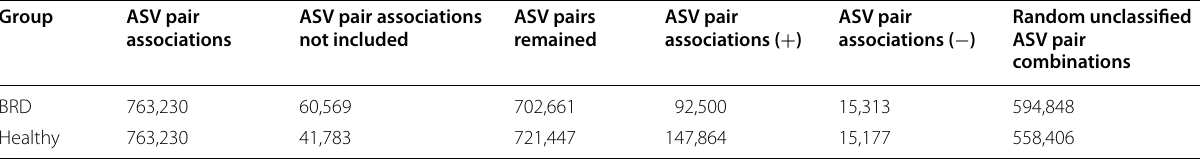
57) and Healthy (n 74) groups = =